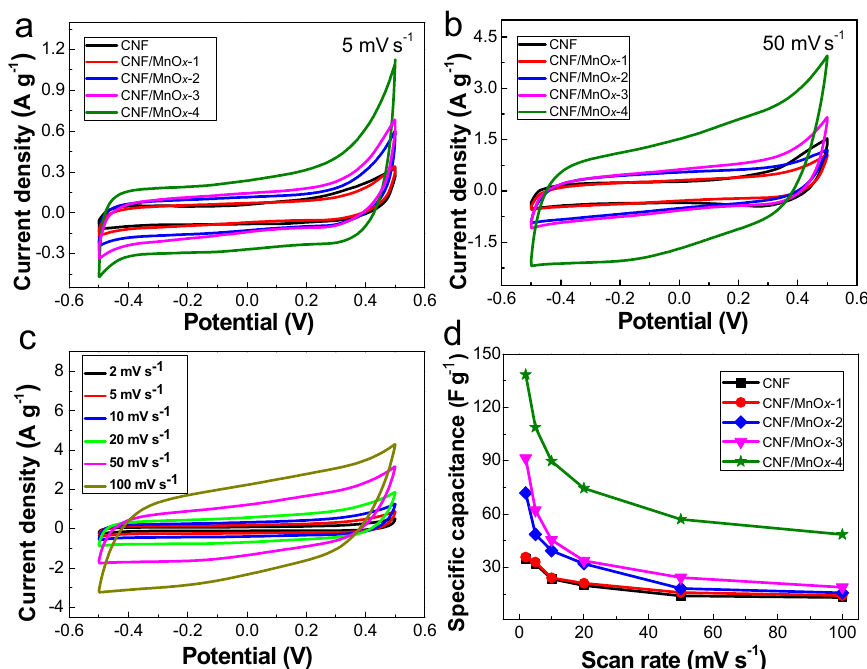
Figure 5. Cyclic voltammetry (CV) curves of the CNF/MnO x electrodes at a scan rate of ( a ) 5 mV s − 1 and ( b ) 50 mV s − 1 . ( c ) Changes of CV curves of CNF/MnO x -4 at scan rates from 2 to 100 mV s − 1 . ( d ) Specific capacitance vs. scan rate.